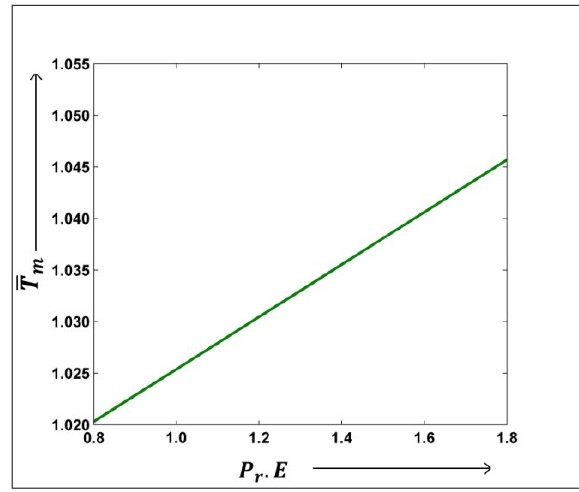
Fig. 4: Mean temperature vs. Thermal parameter at 1/¯ s = 1, ¯ α 2